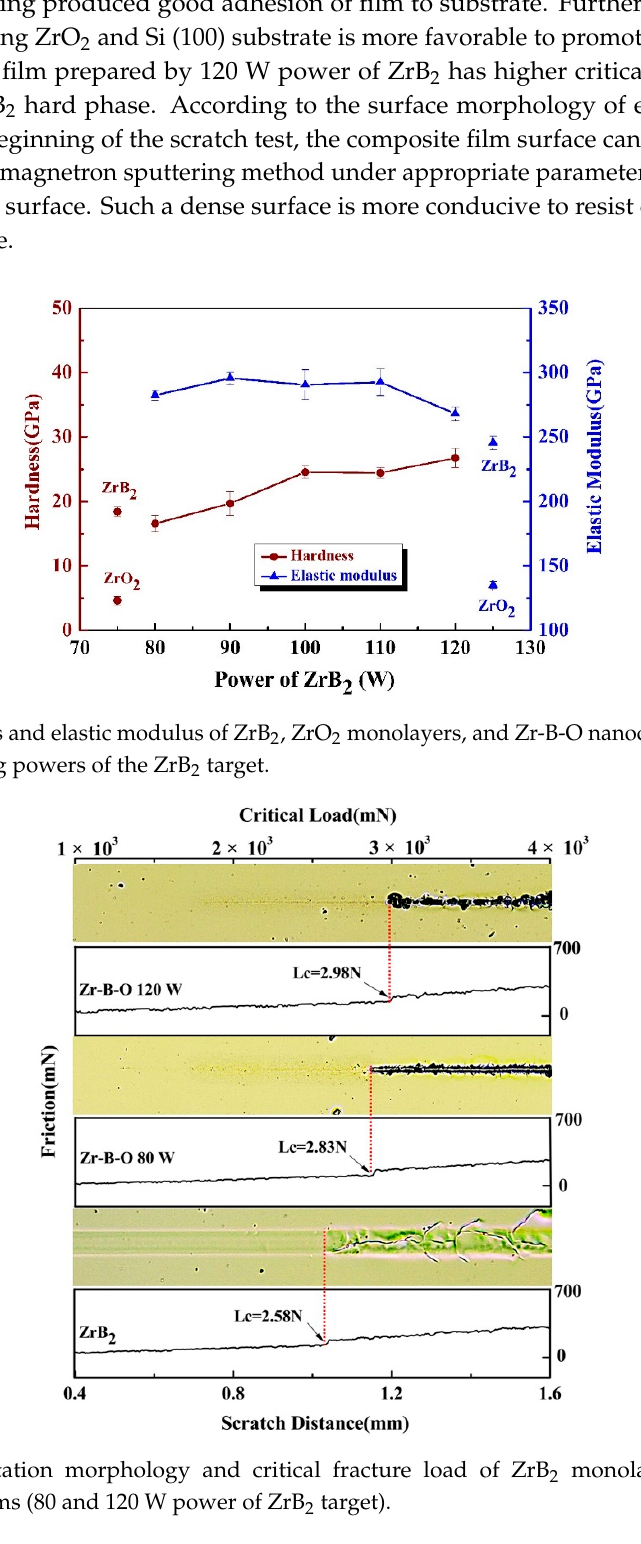
Figure 5. Hardness and elastic modulus of ZrB 2 , ZrO 2 monolayers, and Zr-B-O nanocomposite films at different sputtering powers of the ZrB 2 target.